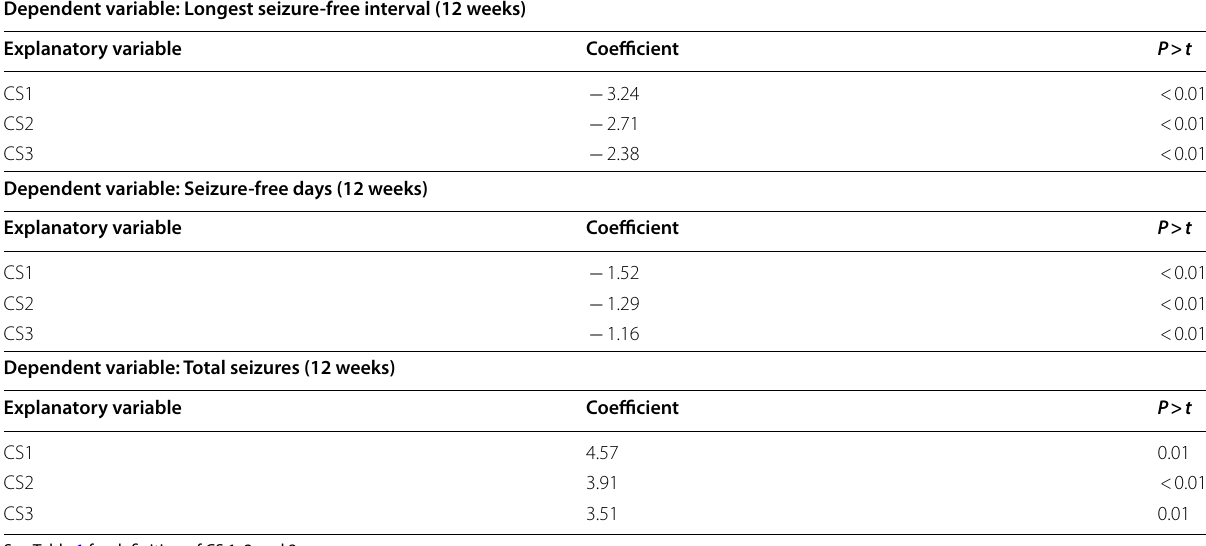
Table 3 Regression analysis of composite symptom scores on 12‑week tonic–clonic seizure